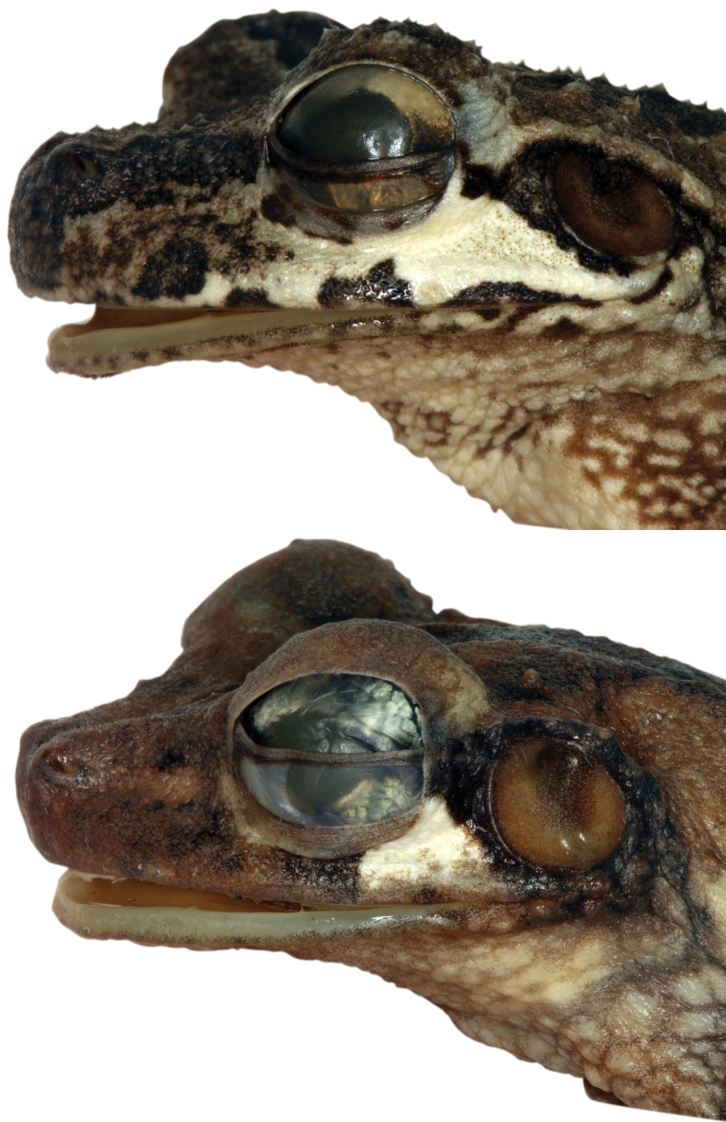
Lateral view of the head of the holotypes of Osteocephalus germani (above CORBIDI 05462) and Osteocephalus vilmae (below CORBIDI 04773).